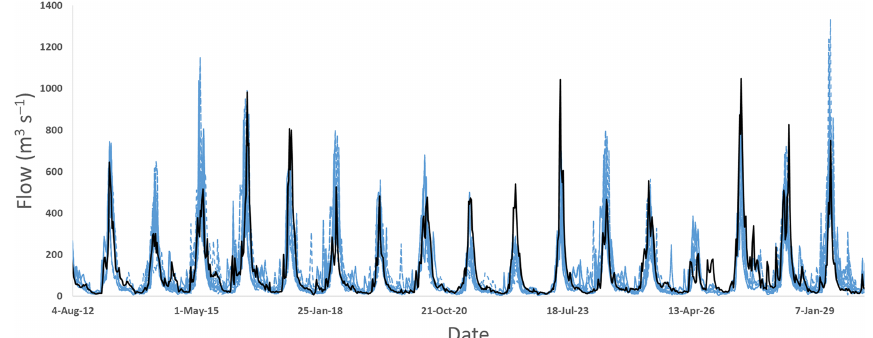
Figure 5. A time series comparison of an ensemble of 30 weekly flow reconstructions (dotted blue) and weekly naturalized flow (solid black) for the Oldman River basin.